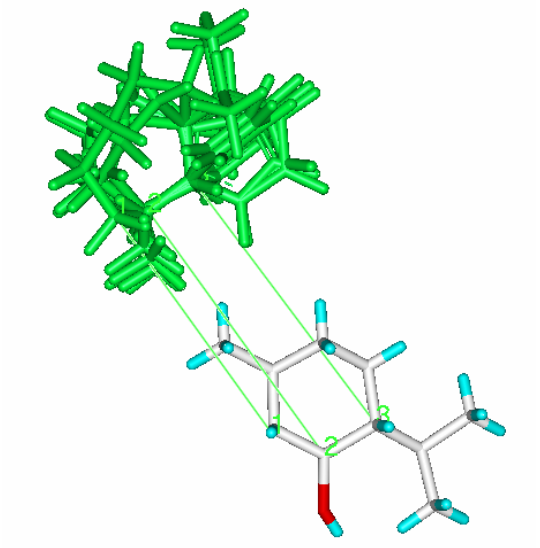
Figure 4. Alignment of menthol to the fitting model of all the substrates oxidized by the yeasts. Example of alignment designed using Accelrys WebLab® Viewer